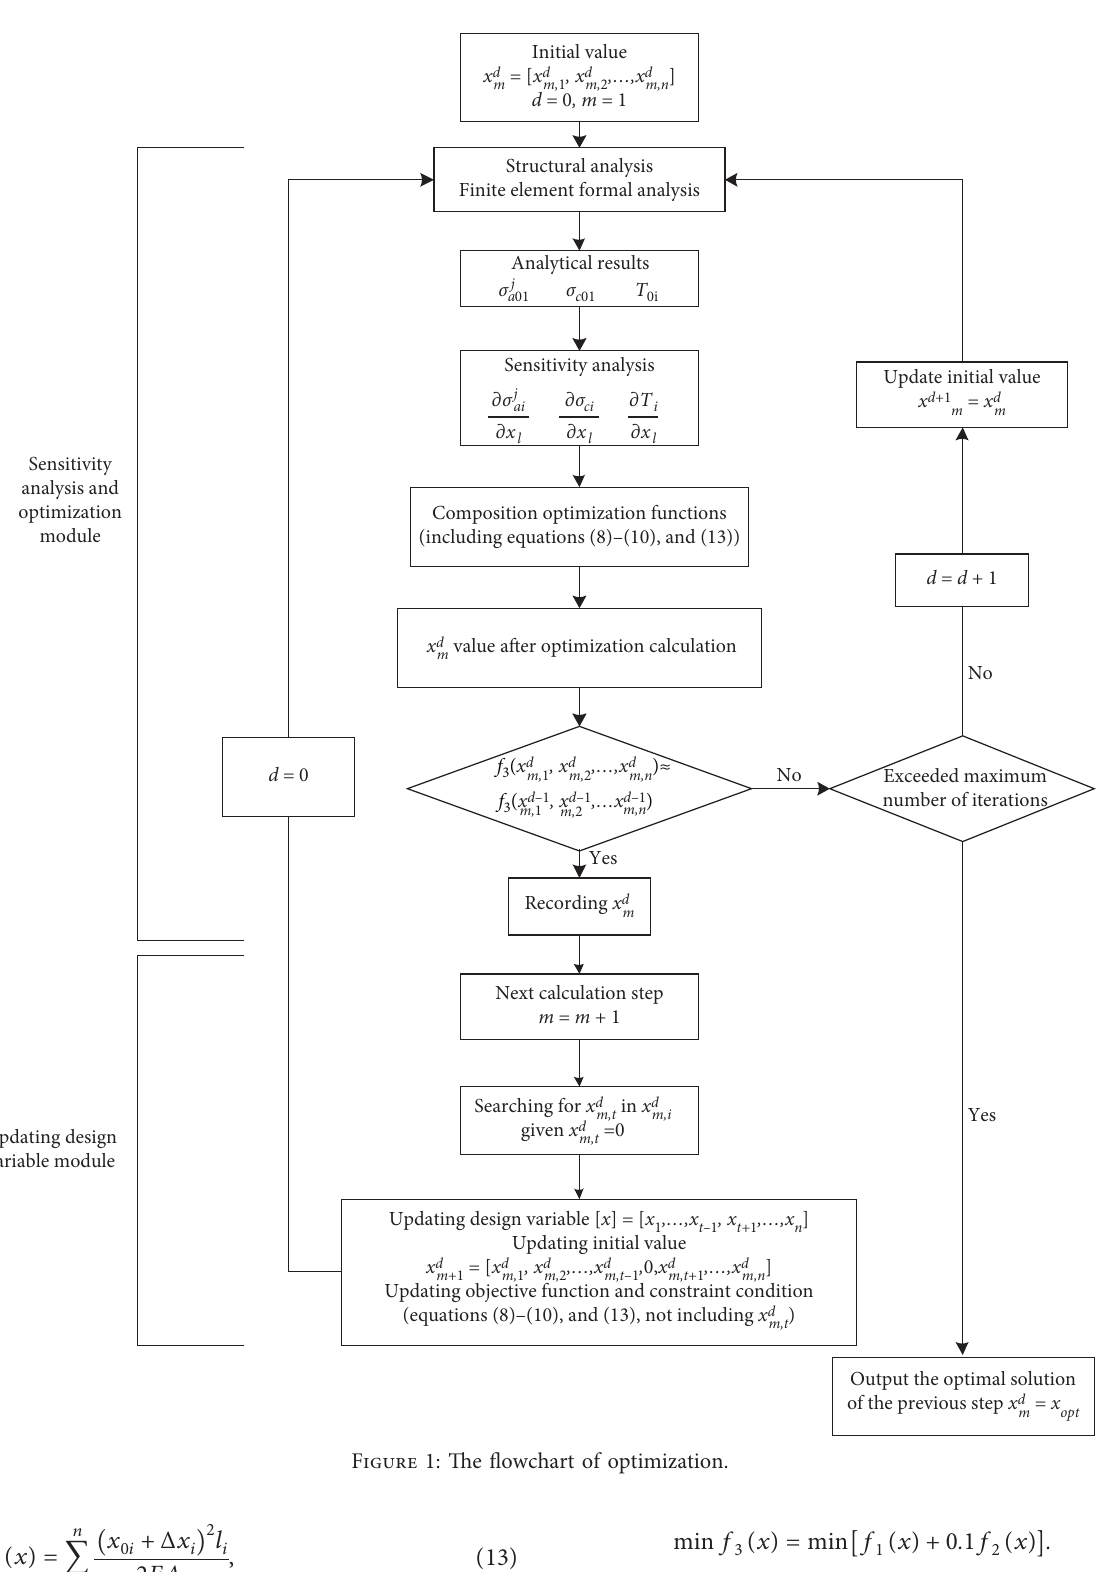
Figure 1: The flowchart of